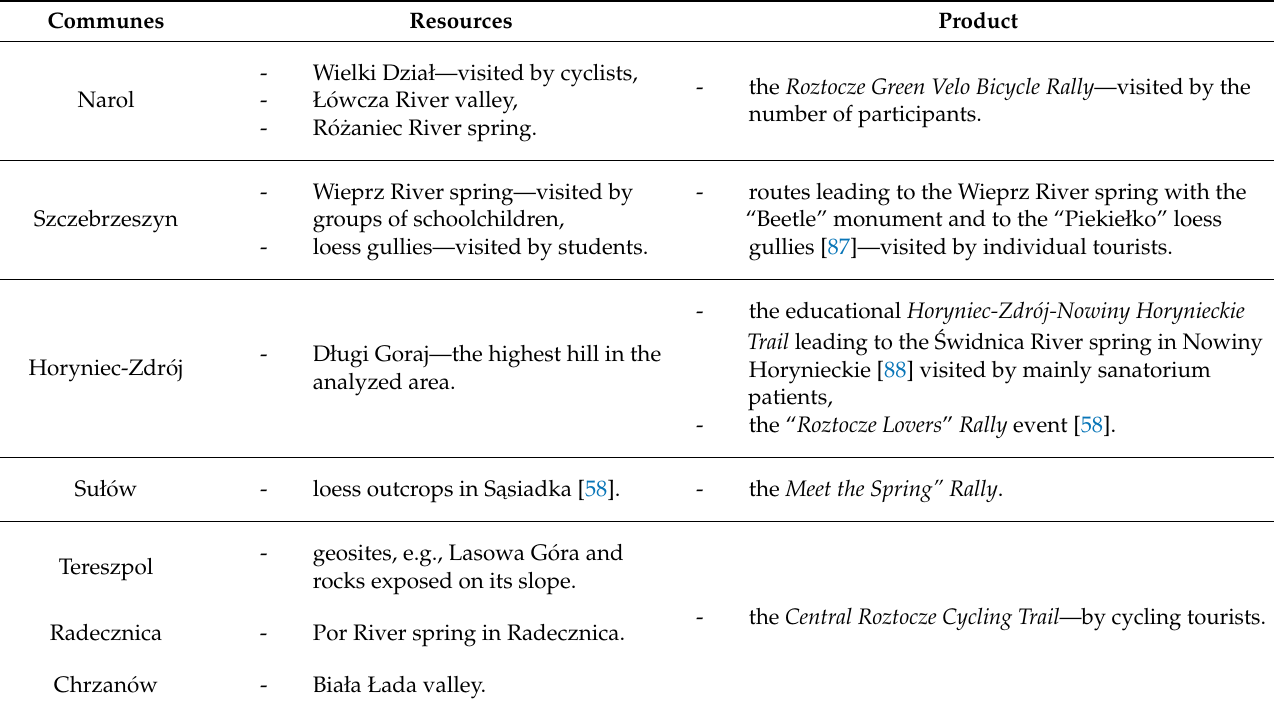
developed geotourism function, attention should be paid to Horyniec-Zdr ó j, where only some of the many resources are visited, mainly by sanatorium patients (Table 15). The landscape assests (hills, valleys) are the most popular among tourists in Narol and Tereszpol communes, likewise in Szczebrzeszyn and Suł ó w communes (loess gullies). Table 15. Communes with a poorly developed (TGFI = 0.001–0.060) geotourism